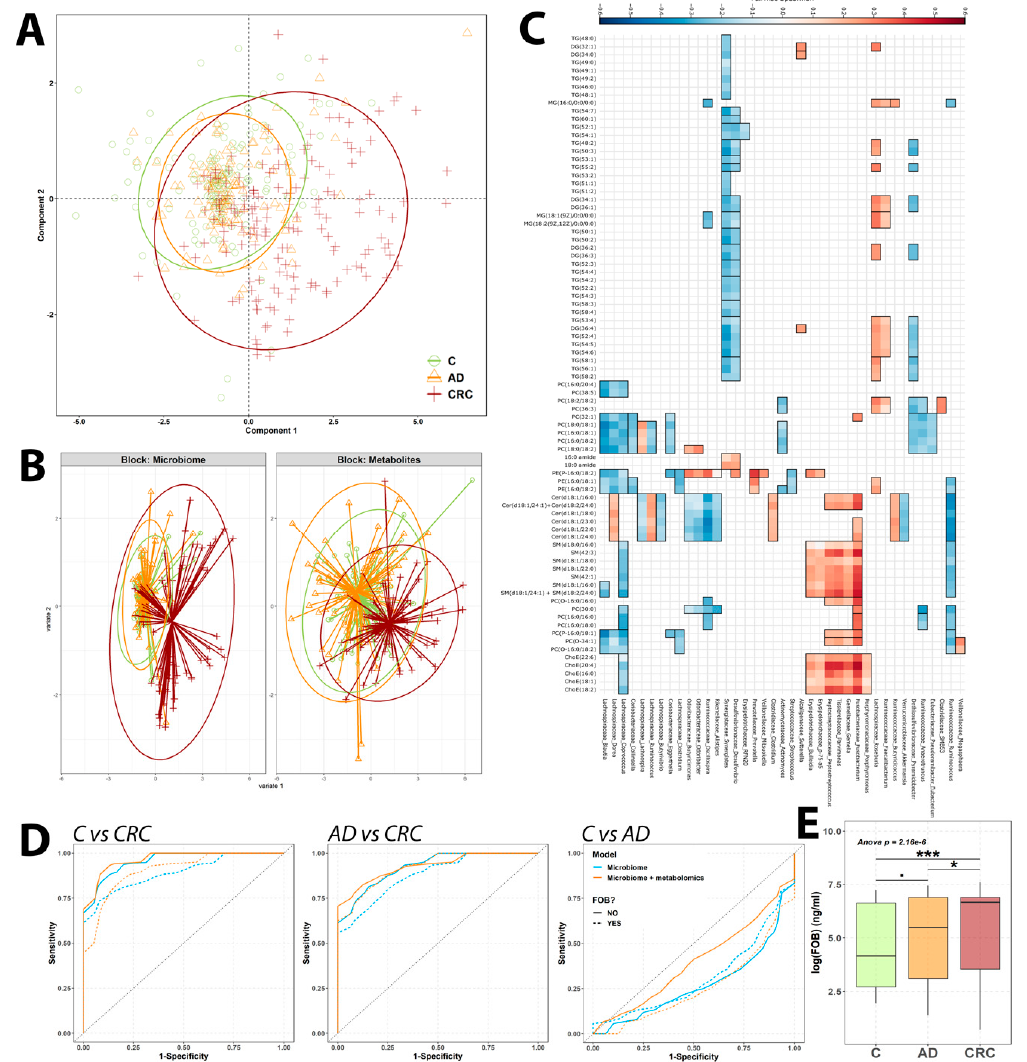
Figure 6. Multi-omics results summary ( A – C ) and metabolomics-microbiome fingerprint LASSO models ROC curves ( D ). mixOmics analysis for the combination of both metabolomics and microbiome data. Block sPLS-DA analysis scores plot for the 3 sample group. Point color and shape depend on the sample clinical status. Ellipses represent the 95% confidence per sample group ( A ); Contribution of each omics dataset to the distribution of the samples depicted in the block sPLS-DA scores plot. Point shape and color depend on the sample clinical status. Lines represent the distance from each sample to the centroid of the corresponding sample group. Ellipses represent the 95% confidence region ( B ); 50 strongest associations resulting from HAllA results, depicting the correlations between bacterial genera, displayed in the vertical axis, and individual metabolites, represented in the horizontal axis. The red color indicated positive correlation values, while blue color negative ones. Only significant correlations have been painted. Correlations have been also clustered depending on the correlation trend so that the genera that correlate with the same metabolites are depicted together ( C ); Median ROC curves for the 10,000 population iterations of the microbiome and microbiome-metabolomics combined models. Line color indicates the data used (blue microbiome, orange combination) and line type the inclusion of FOB measurements on the model (solid without FOB, dashed with FOB) ( D ); FOB measurements distribution per sample group. FOB measurements are indicated in log-scale and ANOVA p -value of the di ff erences between sample groups is indicated. Pairwise comparisons significance levels are indicated as follows: < 0.1, * < 0.05, ** < 0.001 and *** < 0.001 ( E